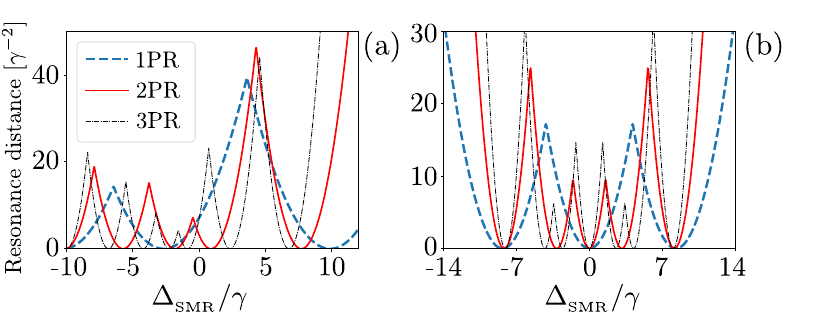
Figure 9. Resonance distances, as defined in Eq. (19), versus the frequency detuning (cid:31) decay rate γ ) between the drive and SMR for: ( a ) the SMR-driven system with parameters specified in Eq. (28) 7.58 γ and ( b ) the QD-driven system with Eq. (29) with g with g =